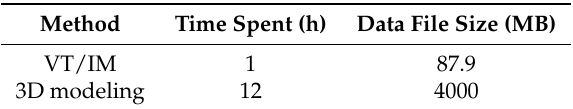
Table 1. Direct comparison of the completion time and data storage requirements for VT/IM and 3D modeling in case of the Streicker